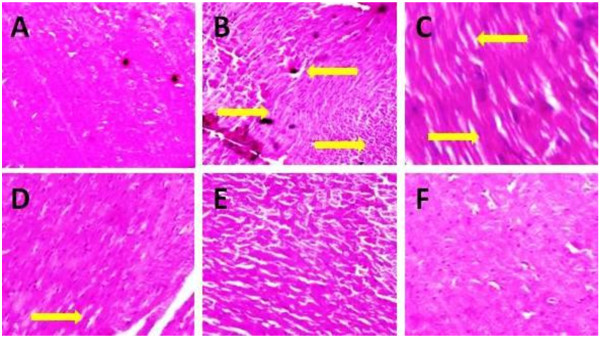
Effect of Umbelliferone β-D-galactopyranoside (UFG) photomicrographs of histological change on heart in different groups of rats: (A) Normal control: Normal control group rat showing normal histopathology. (B) Diabetic control: Increased interstitial space and distort the intercalated disc (yellow arrow) in diabetic control group rat histopathology. (C) UFG I (10 mg/kg): Dose UFG (10 mg/kg) treated group rat showing less interstitial space and intercalated disc (yellow arrow) (D) UFG II (20 mg/kg): Dose UFG (20 mg/kg) treated group rat showing only space in intercalated disc (yellow arrow). (E) UFG III (40 mg/kg): Dose UFG (40 mg/kg) treated group rat did not showing any changes in histopathology of heart. (F) Glibenclamide (10 mg/kg): Glibenclamide (5 mg/kg) treated drug shown the normal histopathology of heart. The samples were obtained from the same liver anatomical regions. For each group, 6 rats were examined and 80 pictures were taken. The above picture for each group was chosen randomly from the 80 pictures in this group. Original magnification, 10 × .